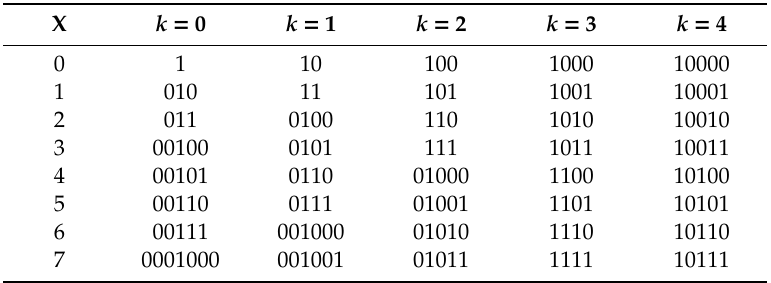
Table 6. Exponential Golomb (EG) encoding example according to k